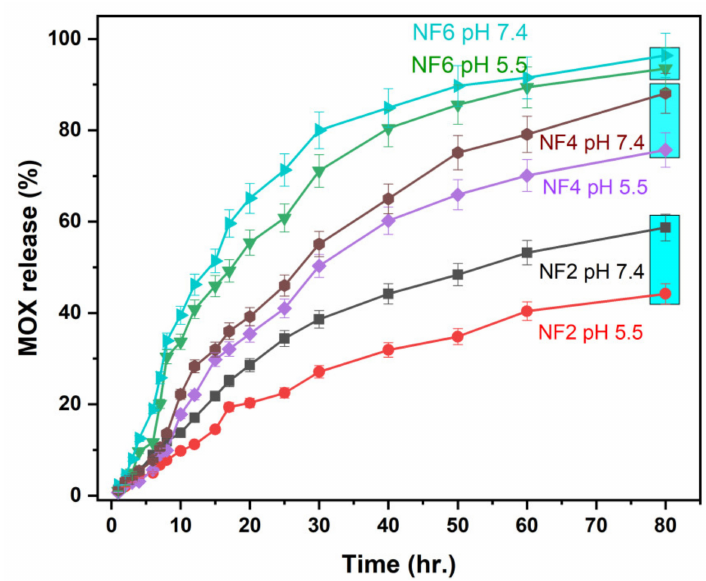
Figure 5. The e ff ect of nanoformulations on in vitro burst drug release of Mox at pH 7.4 and